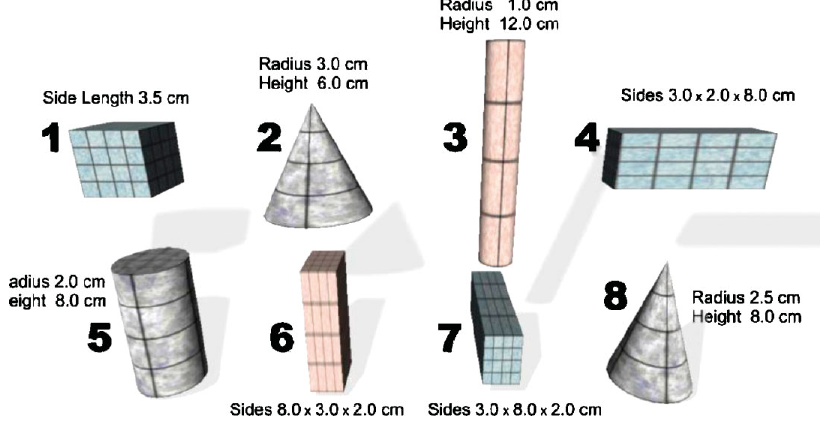
Figure 8. Objects used for testing robots’ generalization ability with respect to object shape and size.